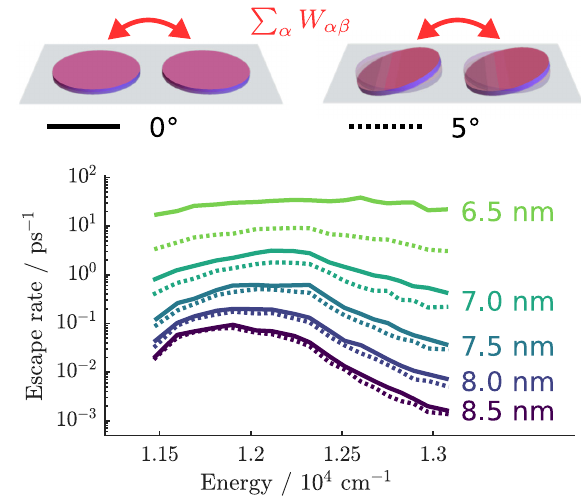
FIG. 9. Energy transfer between tilted B850 rings. Total energy-transfer rate from exciton β to any other exciton α on a neighboring ring (escape rate), as a function of the energy of the initial excitonic state β . Results for coplanar (tilde) rings are shown with solid (dotted) lines, for inter-ring distances ranging from 6.5 nm (green) to 8.5 nm (purple). Even a slight tilt of 5° outside the plane results in a significant reduction of the transfer rate at short inter-ring distances. Results are obtained as averages over 10 3 realizations of static